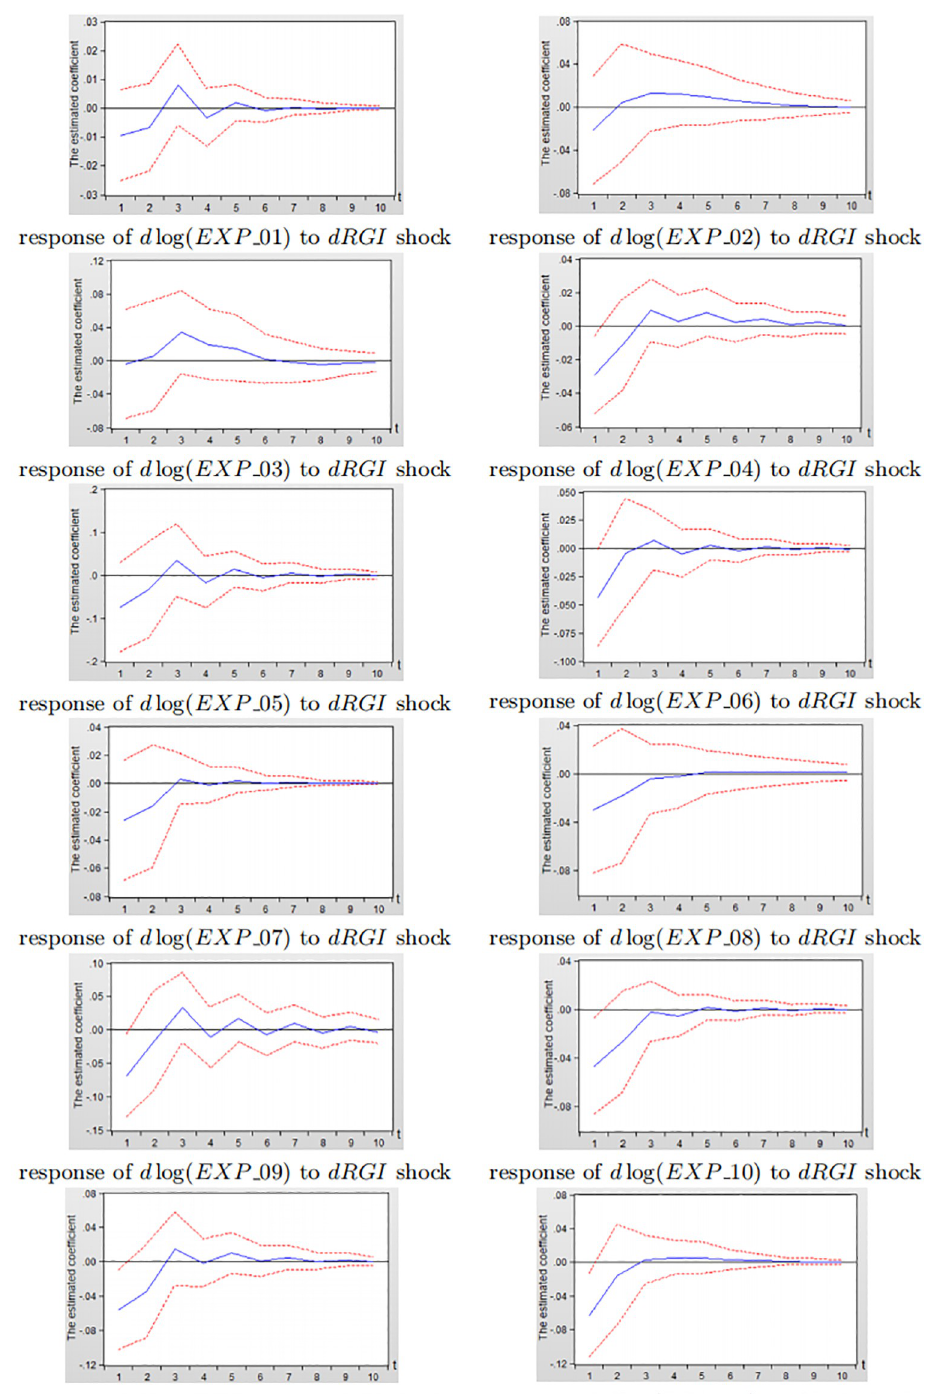
Fig 13. Impulse response diagram of reverse globalization to the United States subdivided manufacturing exports.